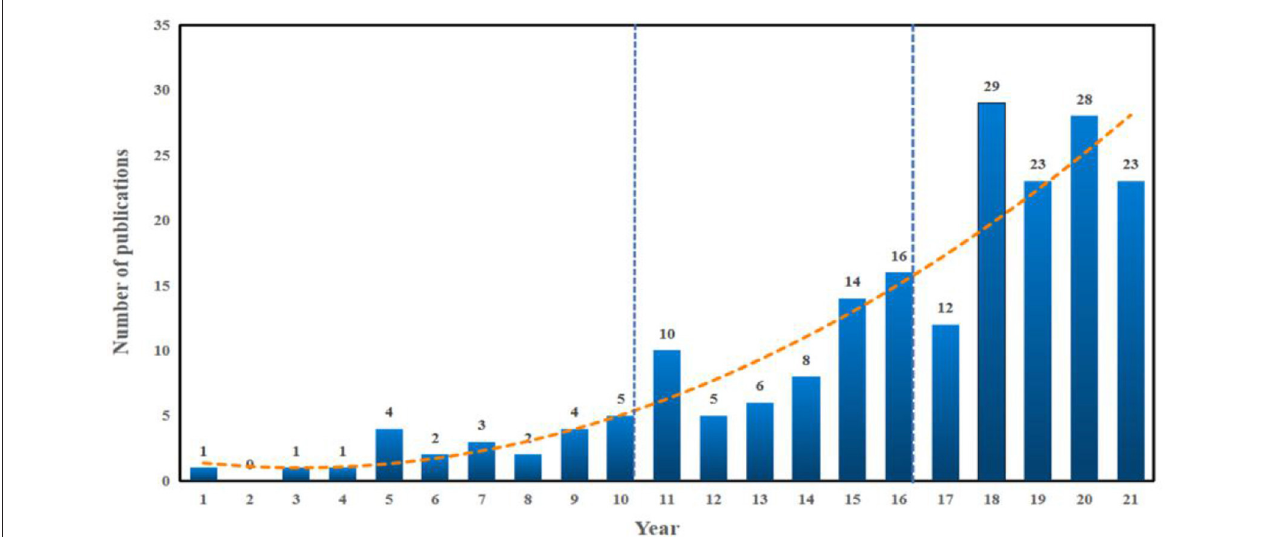
FIGURE 2 | The output of publications and growth trends of pieces of air pollution-physical exercise (AP-PE) research.